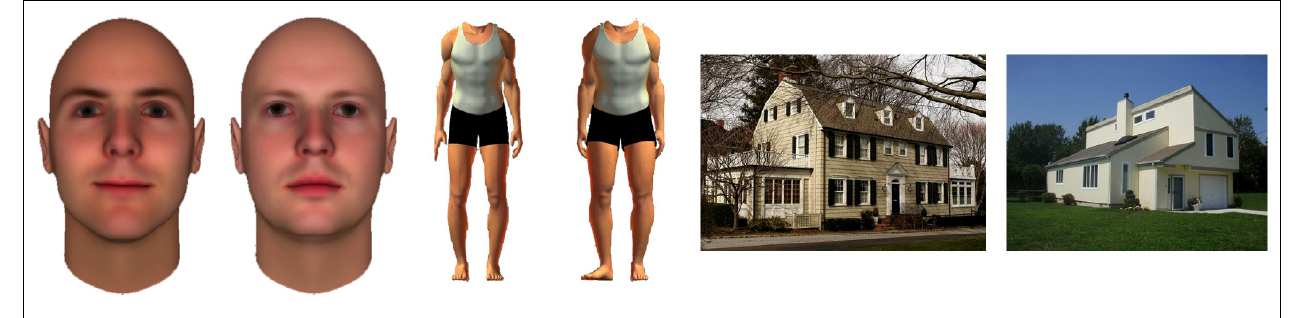
FIGURE 1 | Example images of faces, bodies, and houses. Stimuli were presented in 12-s blocks in pseudo-randomized order. Each run consisted of 12 stimulus blocks (four blocks for each stimulus category), and each